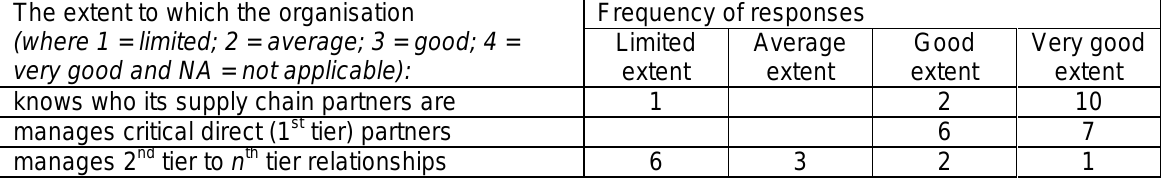
Table 5: Organisations’ relationships with their important customers ( n = 13) The extent to which the organisation